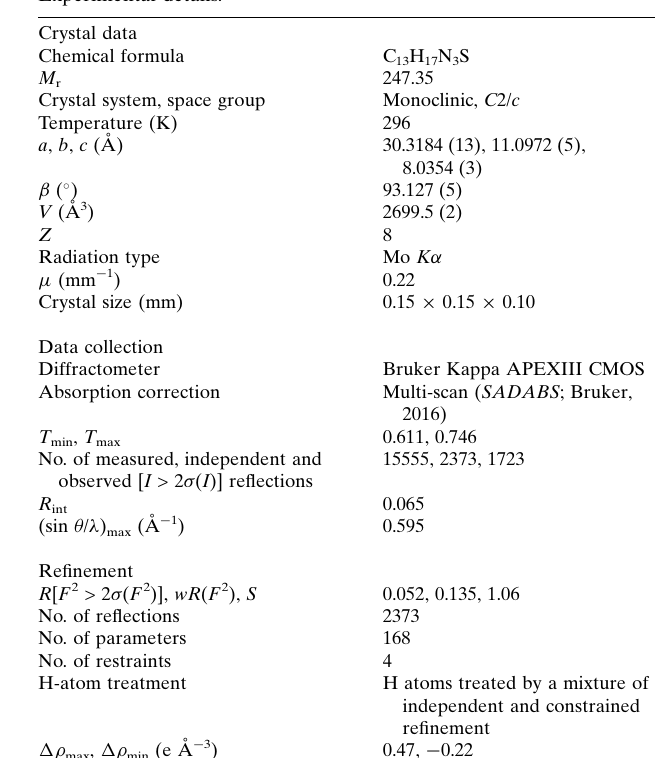
Table 1 Hydrogen-bond geometry (A˚ , (cid:2) ).